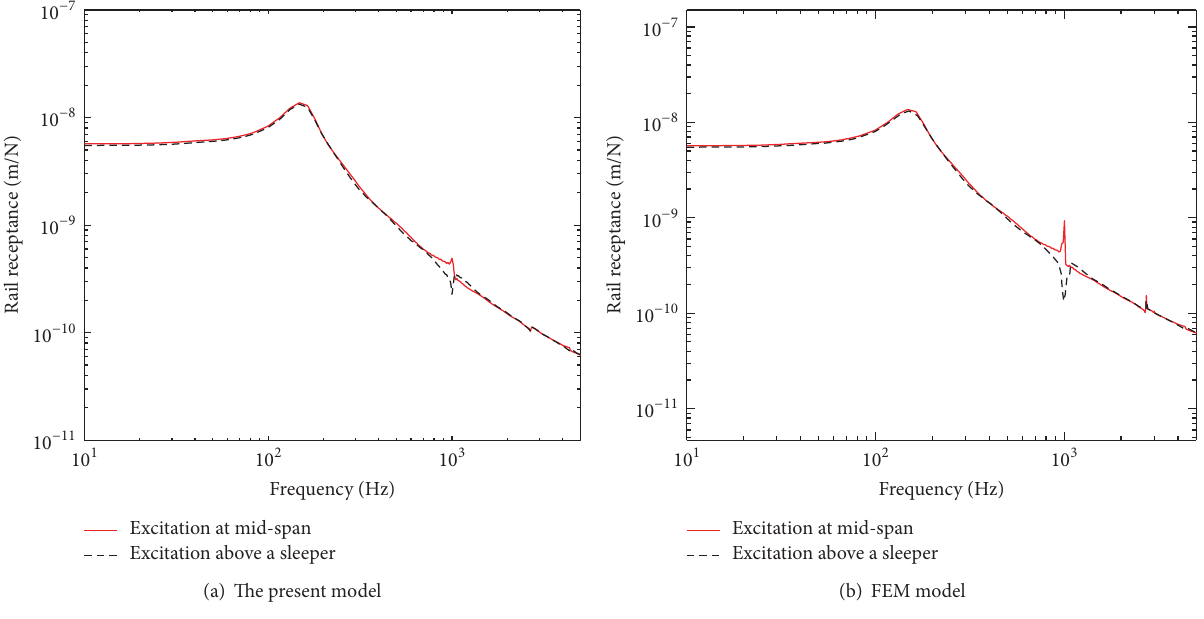
Figure 3: Vertical receptance of the